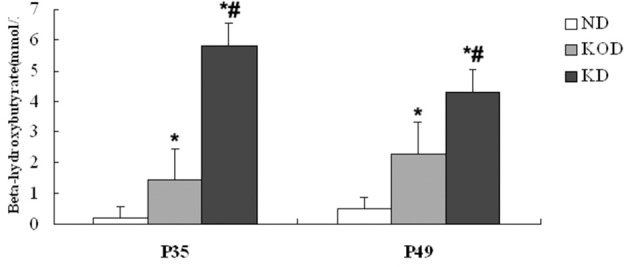
Influence of the KD on blood BHB levels at P35 and P49. *P < 0.001 vs. the ND group;#P < 0.01 vs. the KOD group.